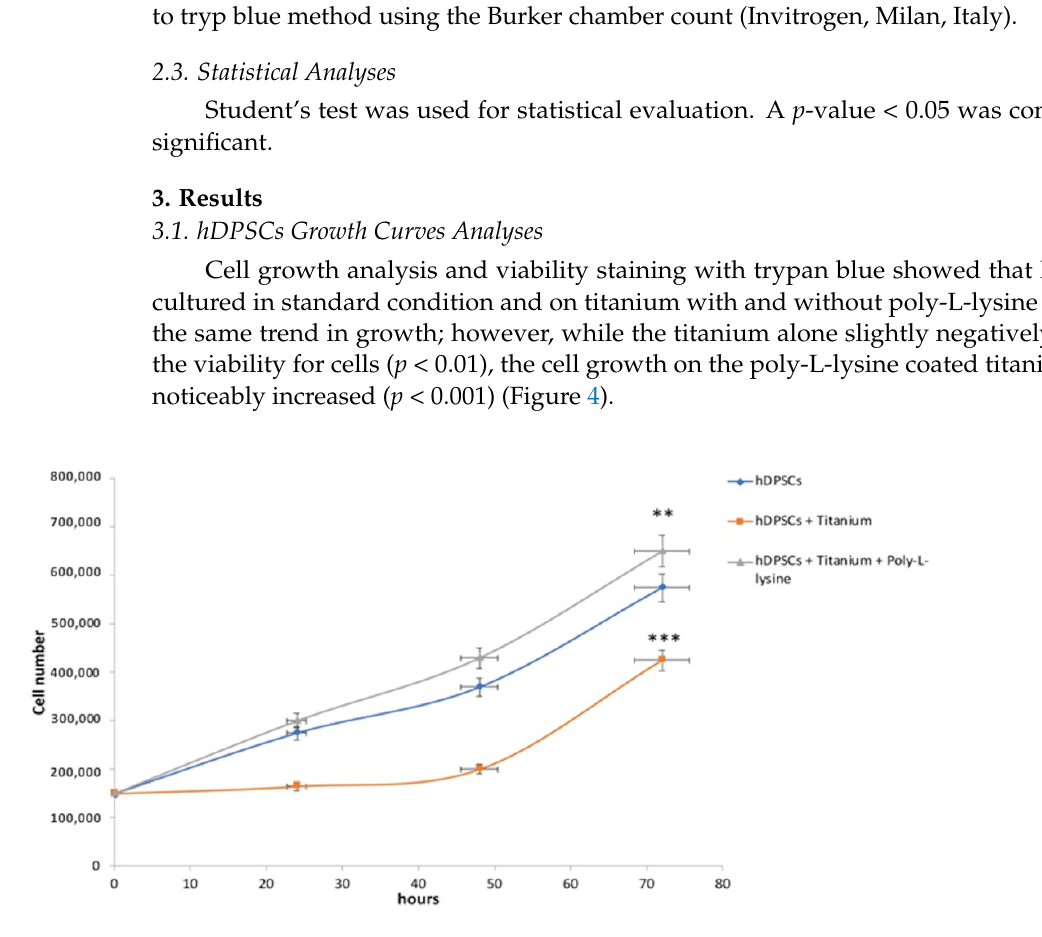
Figure 4. Cell growth analyses. Although hDPSCs cultured in standard condition and on titanium with and without poly-L-lysine showed the same trend in growth, in the culture with titanium coated with poly-L-liysine, the cell growth was higher than the hDPSCs alone and hDPSCs with only titanium. ** p < 0.01, *** p < 0.001 compared to the hDPSCs.